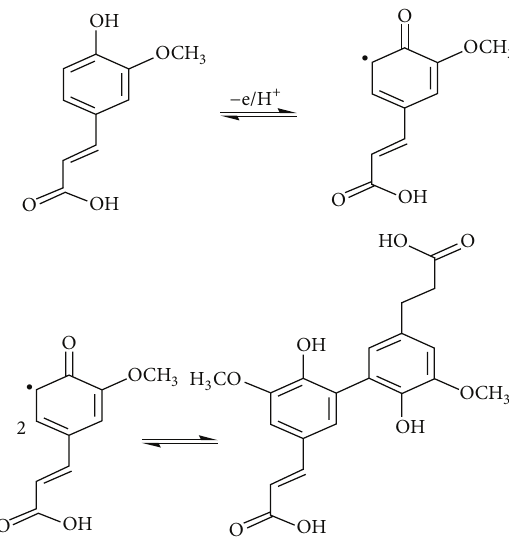
Scheme 1: Electrode oxidation reaction equation of FA at electrode